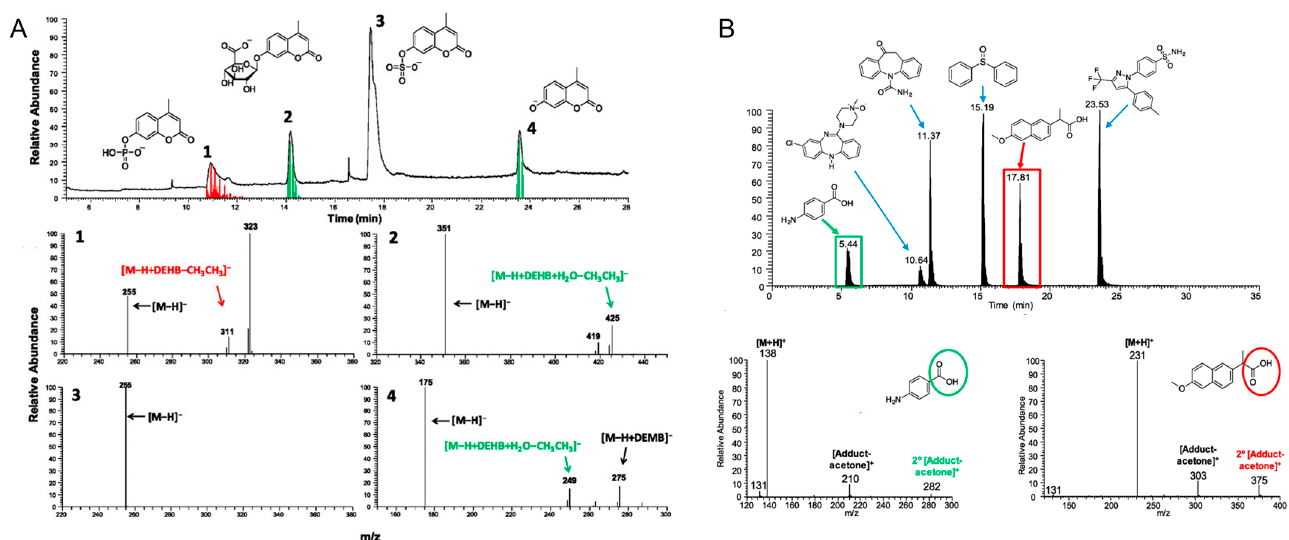
Figure 7. ( A ) Identification and differentiation of a deprotonated hypercromone and its three metabolites using HPLC coupled with diagnostic ion–molecule reactions using diethylmethoxyborane and water [140]. Diagnostic products are labelled in red and green. DEHB and diethylhydroxyborane are produced upon hydrolysis of DEMB. ( B ) The identification of carboxylic acids in a mixture containing compounds, along with other functional groups, using HPLC coupled with diagnostic ion–molecule reactions with (isopropenoxy)trimethylsilane [141]. Diagnostic products are labelled in red and green. Adjusted and reprinted with permissions from the American Chemical Society ( A ) and Elsevier ( B ).